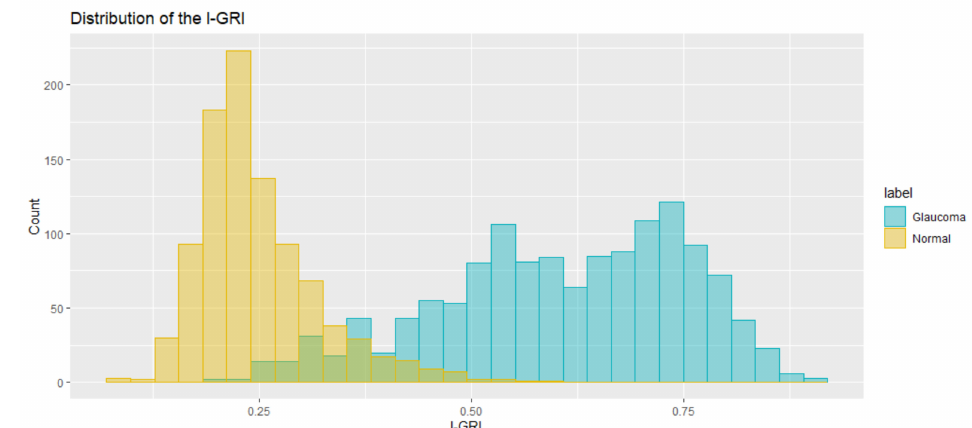
Figure 4. Distribution of the I-GRI values for the reference dataset.